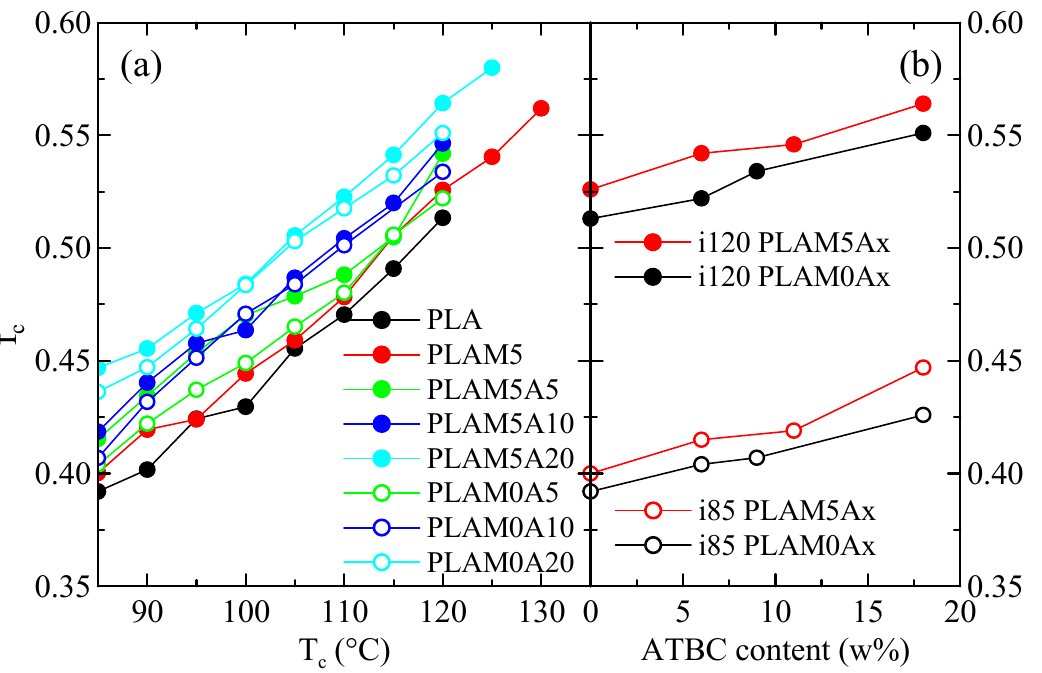
Figure 13. Variation of the DSC crystallinity, normalized to the actual PLA content, for the experiments conducted from the melt, as a function of T c for the different samples ( a ), and of the ATBC content after isothermal crystallization at 85 and 120 °C for the two series of samples ( b ).